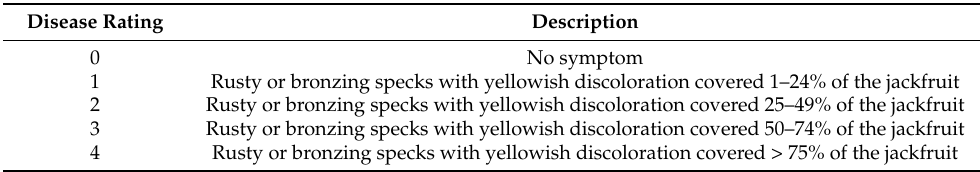
Table 3. The disease rating of rusty or bronzing specks with yellowish discoloration of jackfruit pulps (developed from this